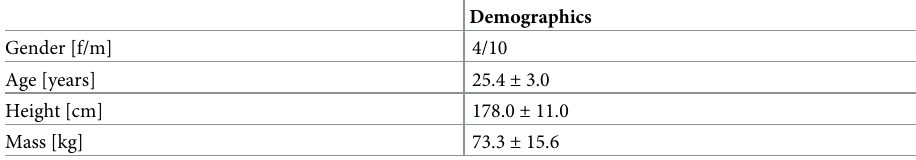
Table 1. Participant